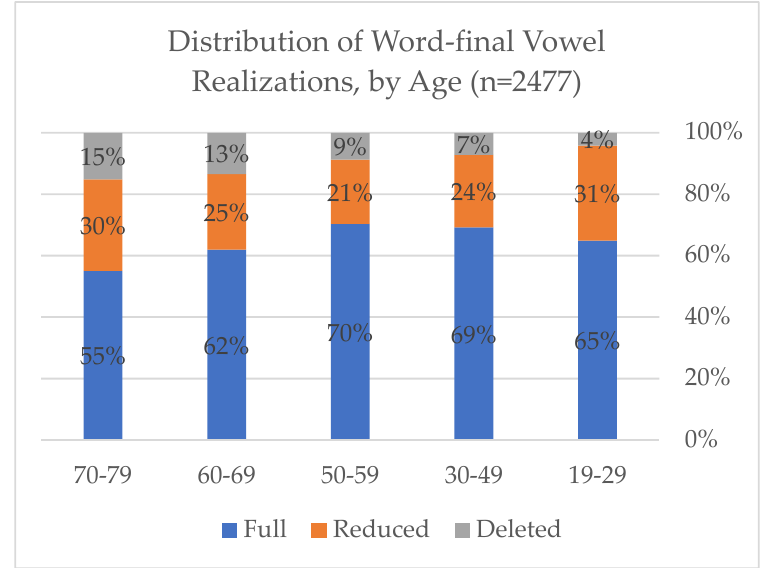
Figure 2. Distribution of vowel realizations by age.